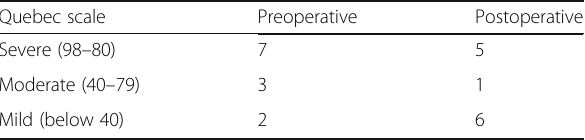
Table 5 Assessment of pain on daily activities using the Quebec scale among our patients Quebec scale